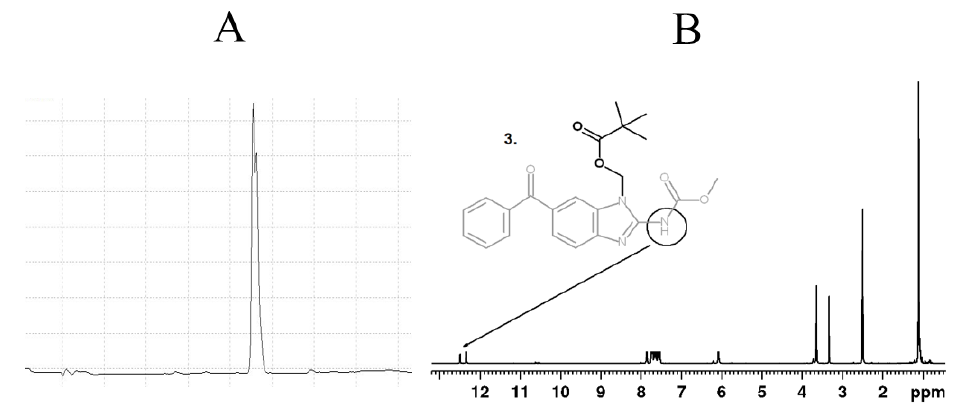
Figure 5. HPLC chromatogram at 300 nm ( A ) and 1 H NMR spectrum of derivative 3 ( B ).